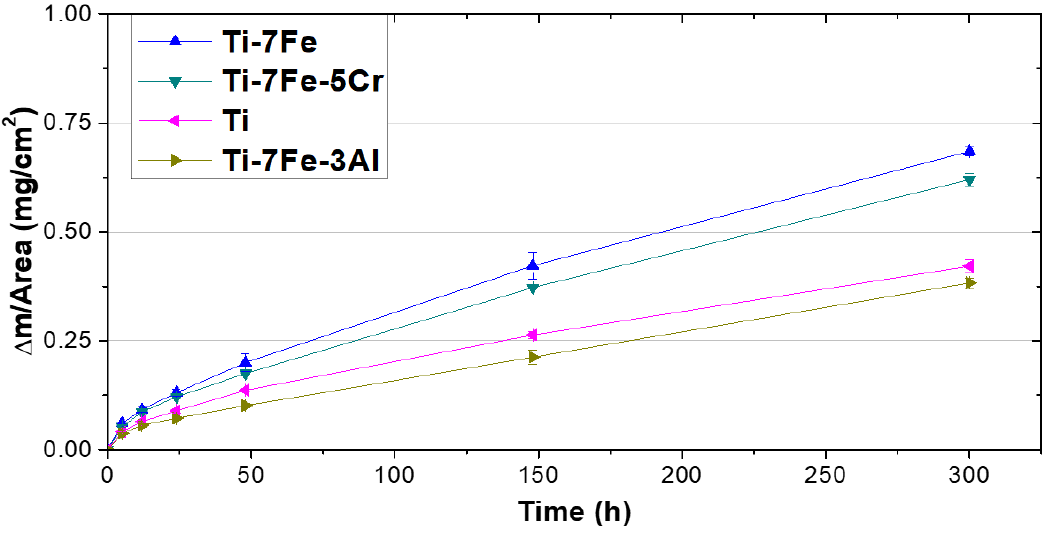
Figure 11. Mass gain as exposure time increase in the 500 ◦ C oxidation test for 300 h of Ti-7Fe-5Cr, Ti-7Fe, Ti-7Fe-3Al, and unalloyed Ti powder metallurgy samples. Cross section of Ti-7Fe and Ti-7Fe-5Cr samples after 500 C oxidation test for 300 h are shown in